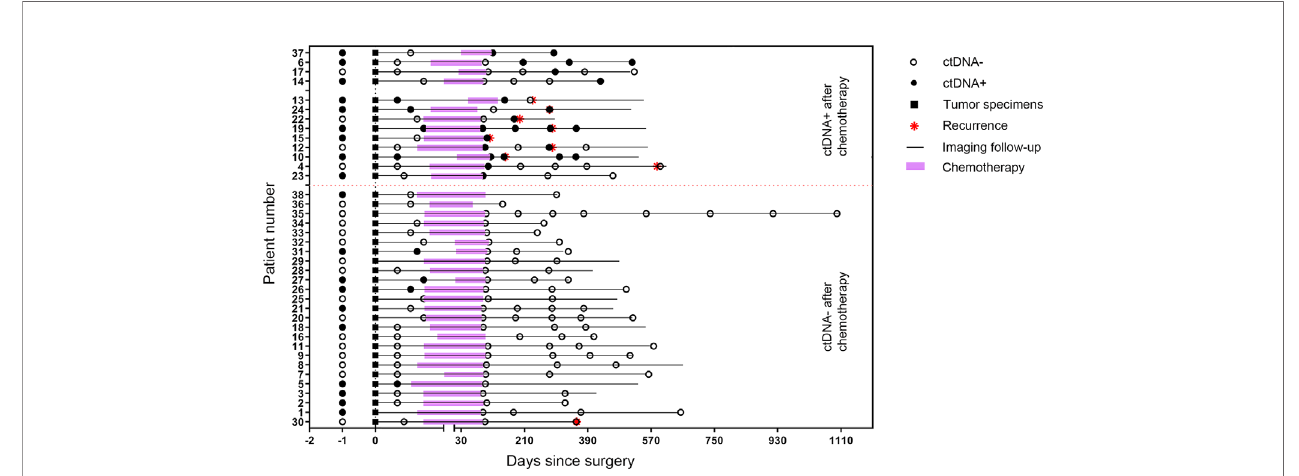
FIGURE 3 | Longitudinal ctDNA pro fi ling results and recurrence status of the 38 patients strati fi ed by post-chemotherapy ctDNA